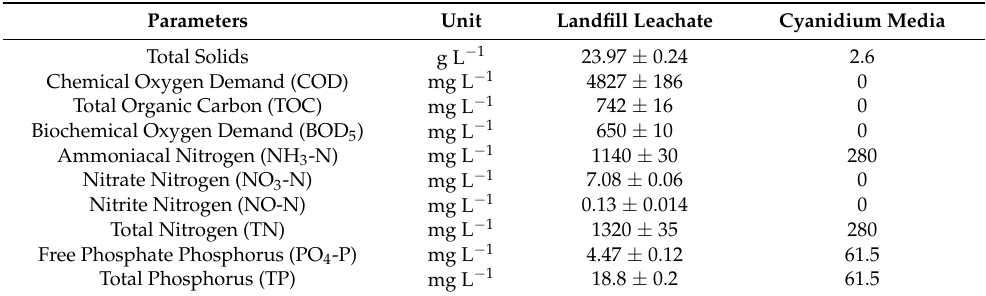
Table 1. Characteristics of landfill leachate and Cyanidium media. Values represent the average ± SD of a minimum of 3 analytical